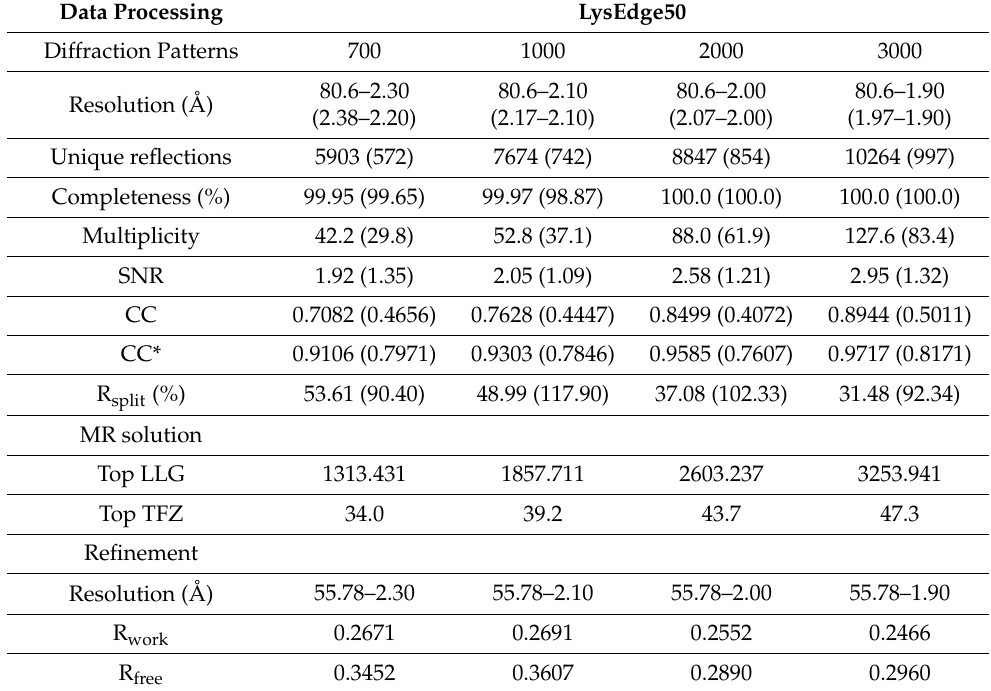
Table 3. Data collection and refinement